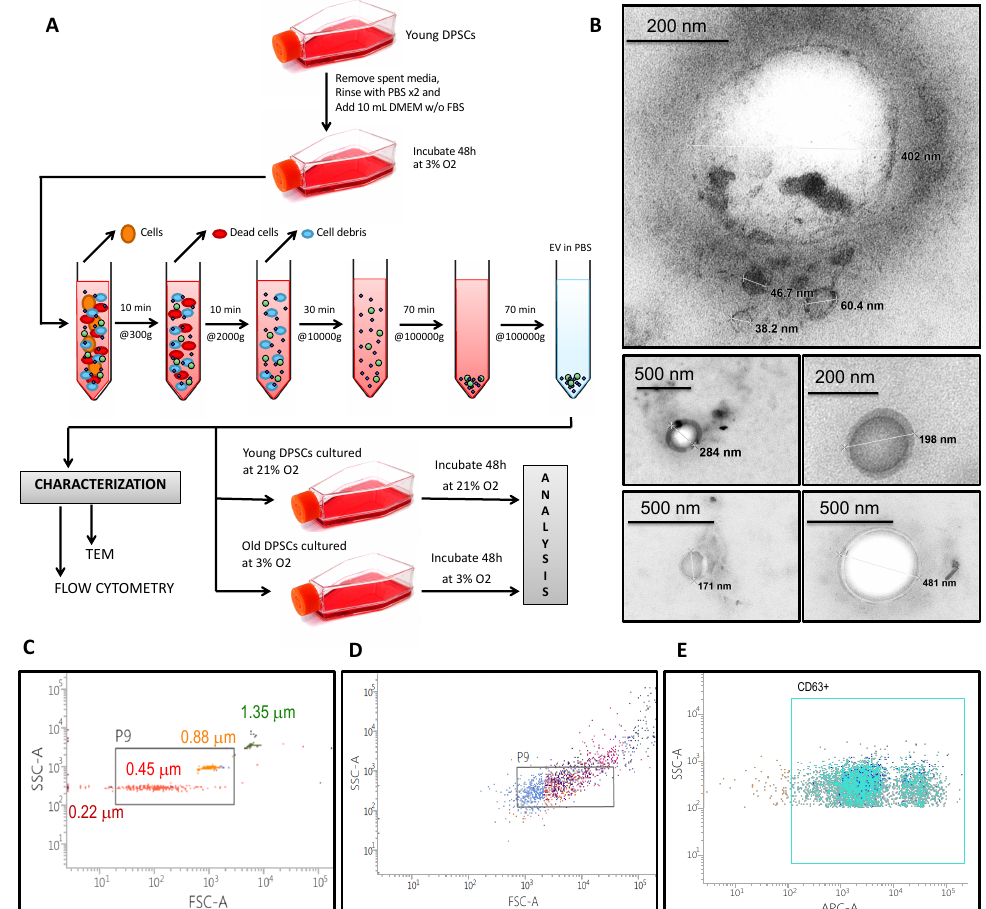
Figure 1. EV characterization. ( A ) Schematic presentation of the experimental workflow to obtain extracellular vesicles. ( B ) Transmission electron microscopy images of EVs derived from hDPSC cultures. Sphere-shaped structures, with 35–500 nm size were identified as EVs. ( C – E ) Flow cytometry characterization: ( C ) Standard size beads: 0.22 µ m, 0.45 µ m, 0.88 µ m and 1.35 µ m, ( D ) EVs and ( E ) EVs with positive CD63